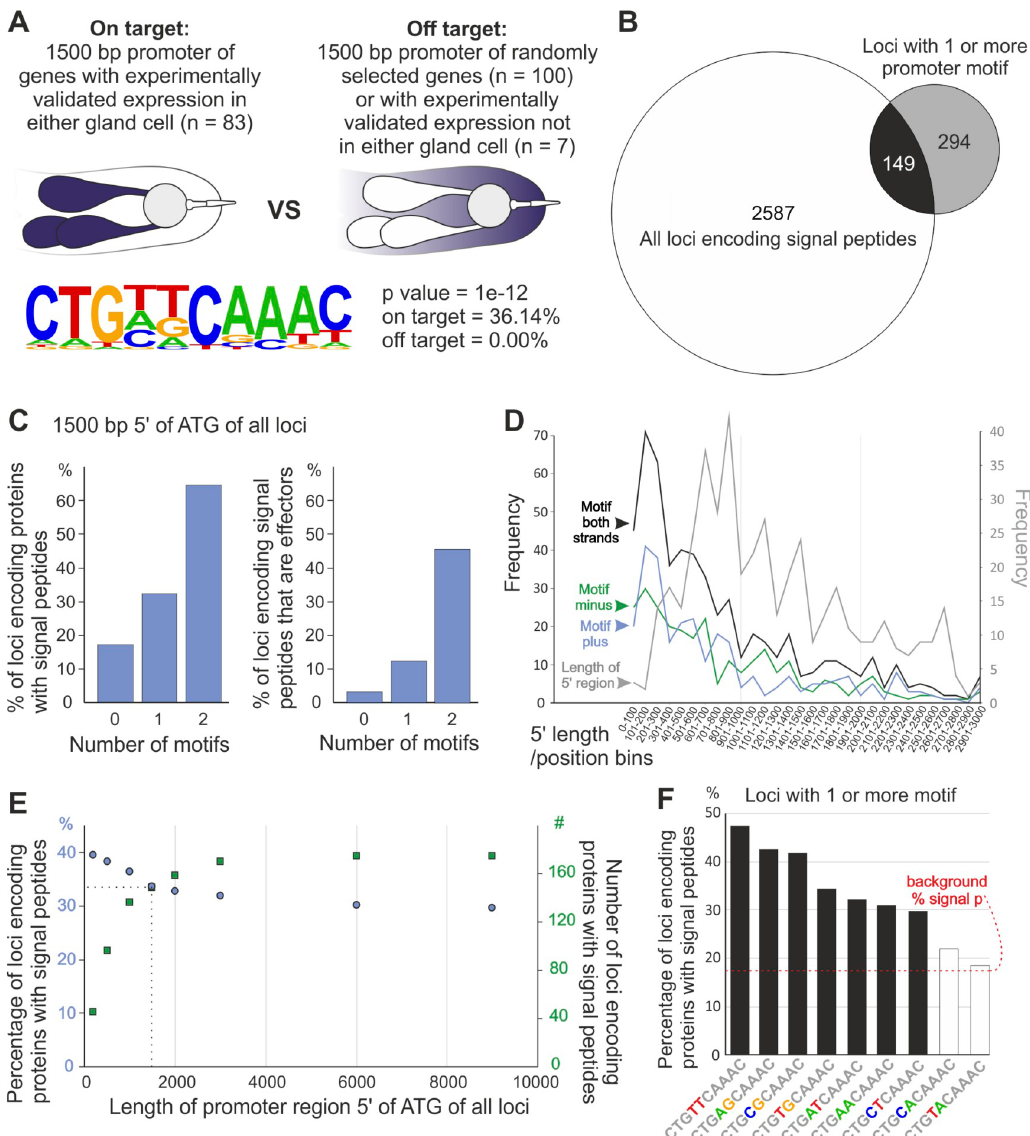
Fig 5. Identification of a non-coding motif associated with subventral gland cell expression in Radopholus similis : the Rs- SUG box. (A) Graphic representation of the strategy applied to identify a highly enriched consensus motif of 10 nucleotides (CTG[T|A|C][T|G|A]CAAAC) in the promoter region of gland effector genes. (B) Number of genes coding predicted secreted proteins containing at least one motif in the promoter region (n = 149). (C) The more motifs present in the promoter region, the more likely is that the corresponding gene will contain a signal peptide for secretion. (D) The frequency of the motif peaks mainly in the 100–300 bp upstream the start codon and is non-strand specific. (E) The distribution of the motif within the 1,500 bp upstream the start codon correlates with genes coding putative secreted proteins. (F) Graphic representation of the motif variant combinations. Seven (black bars) out of the nine variants showed enrichment for putatively secreted proteins.